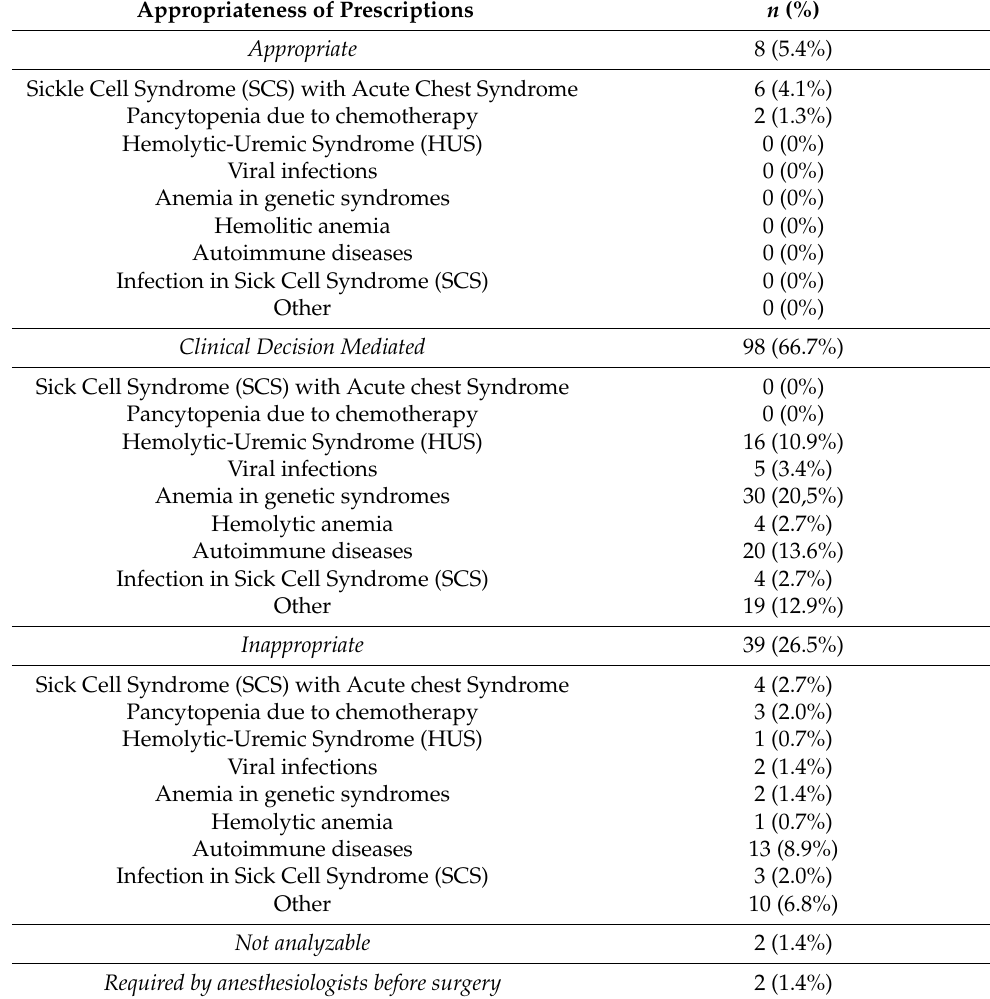
Table 4. Appropriateness of blood component transfusions ( n = 147) performed between 2018–2022 in accordance with NHS